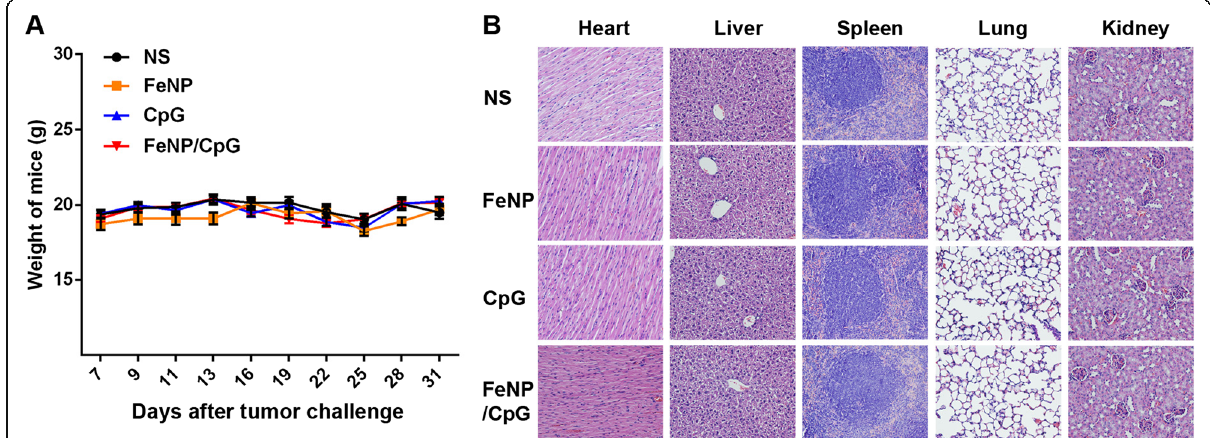
Fig. 6 Safety and toxicity evaluation of FeNP/CpG formulation. ( a ) Body weight changes in NS, FeNP, CpG, and FeNP/CpG groups. b The section of the heart, liver, spleen, lung, and kidney in each group was collected and stained with H&E staining. No significantly pathological changes were observed in any group (magnification, ×